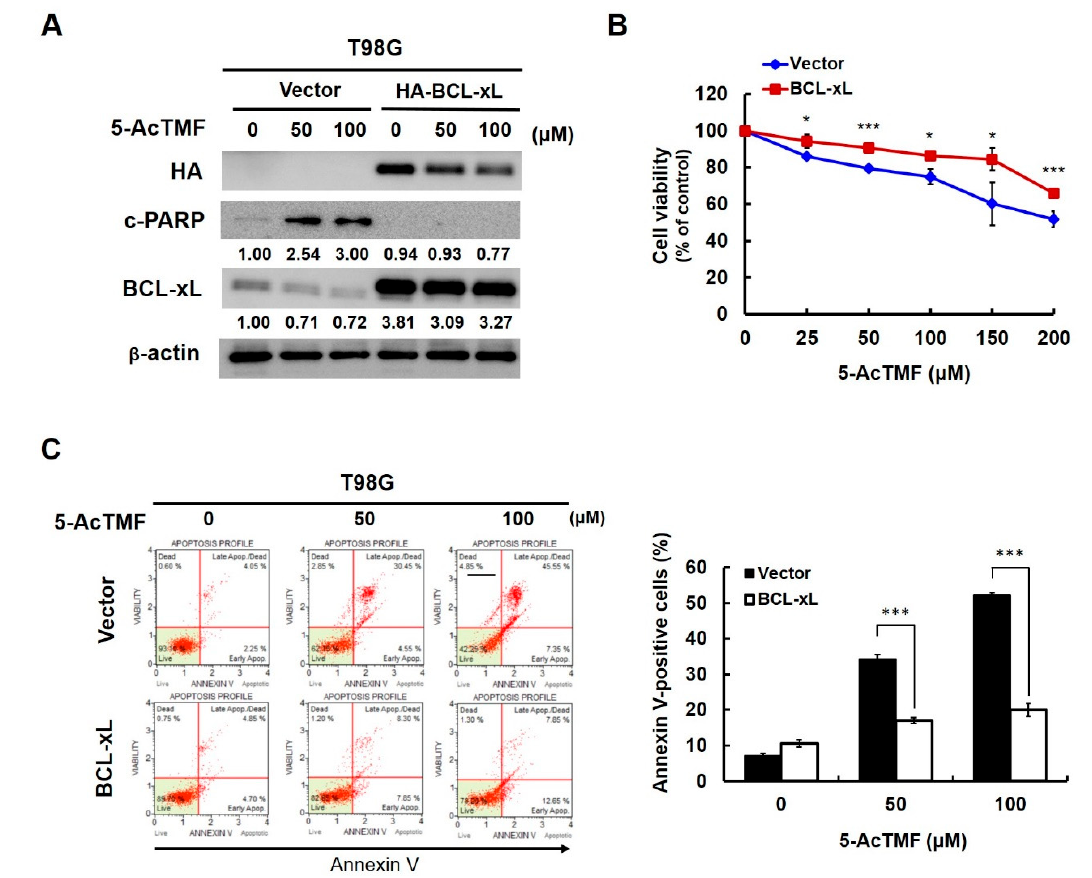
ff ect of 5-AcTMF on